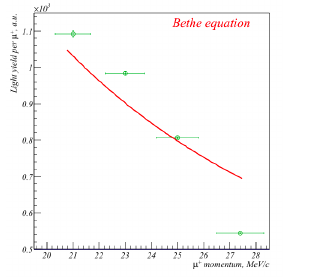
Figure 4. Comparison of hor- izontal beam projections, pic- tures taken from mylar and scintillator sides.